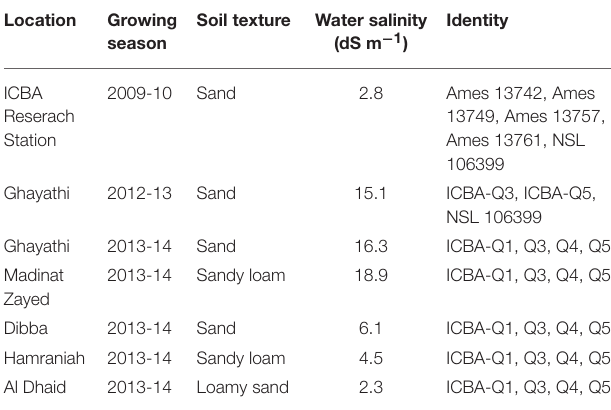
TABLE 2 | Quinoa yield trails in the UAE: Soil and water characteristics at the locations and details of accessions evaluated (Rao, 2016).